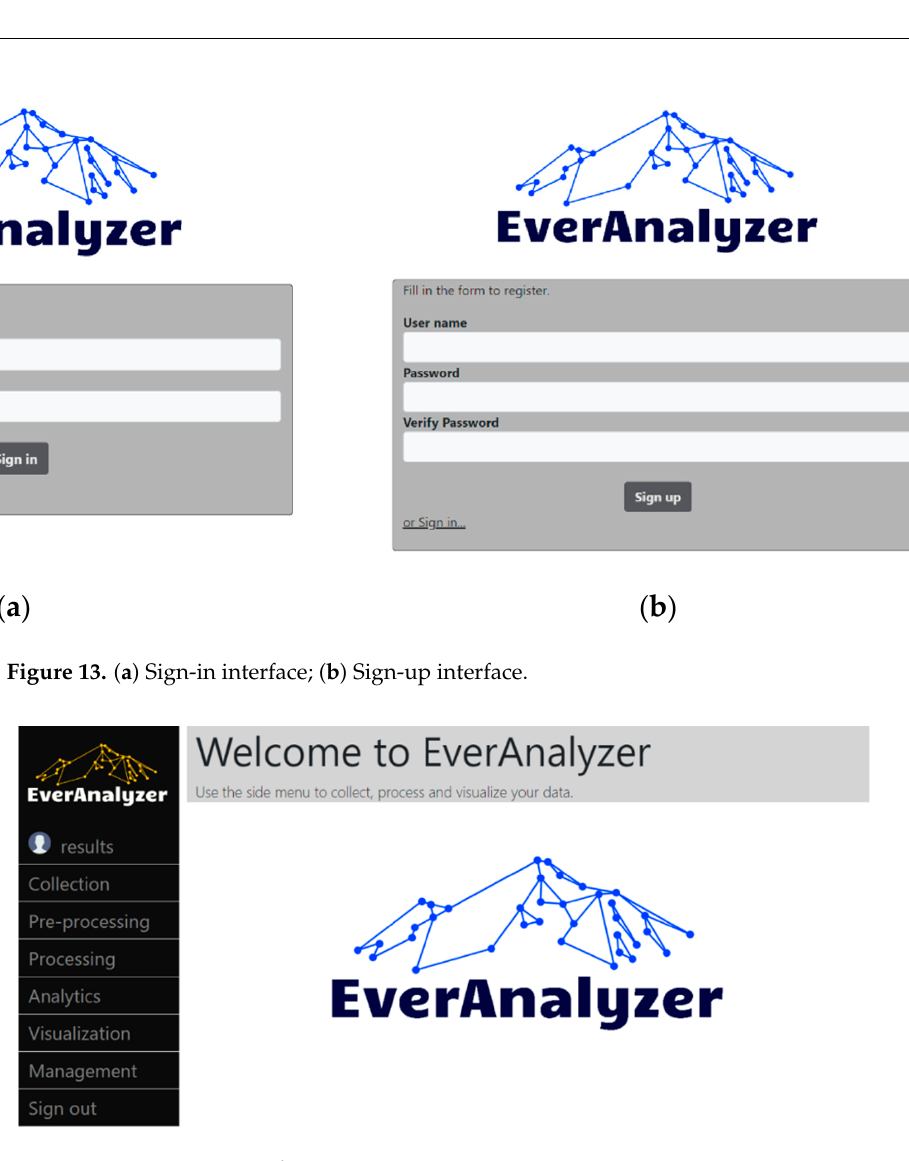
Figure 14. Homepage Interface.